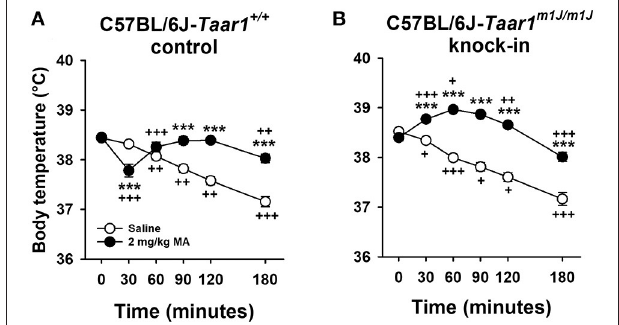
FIGURE 8 | C57BL/6J- Taar1 m 1 J / m 1 J KI mice display MA-induced hyperthermia, whereas C57BL/6J- Taar1 + / + control mice exhibit